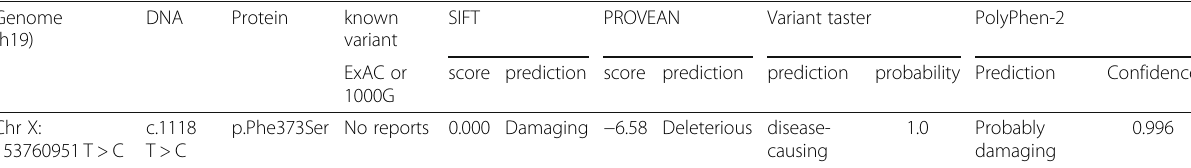
Table 3 Disease causing variant and phenotype in Chinese patients with D-G6PD and hemizygote missense variant in